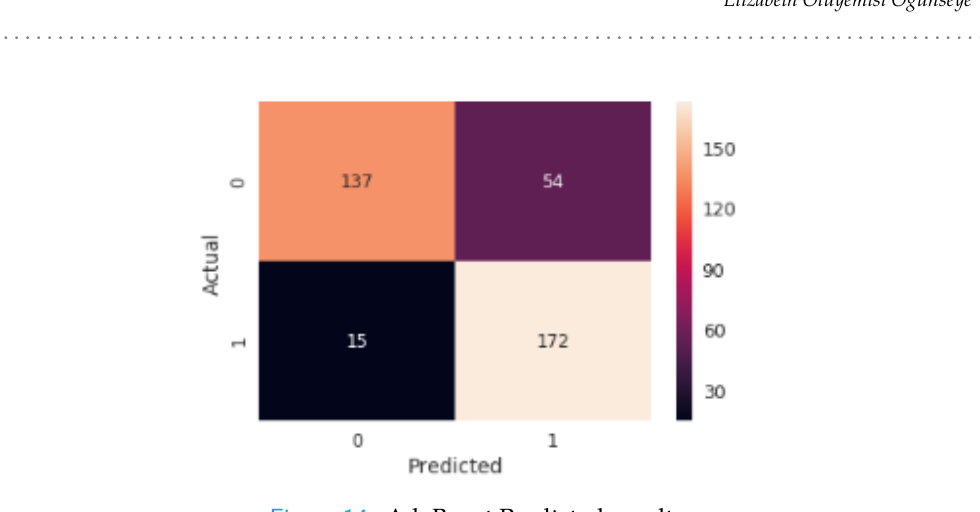
Figure 14: AdaBoost Predicted